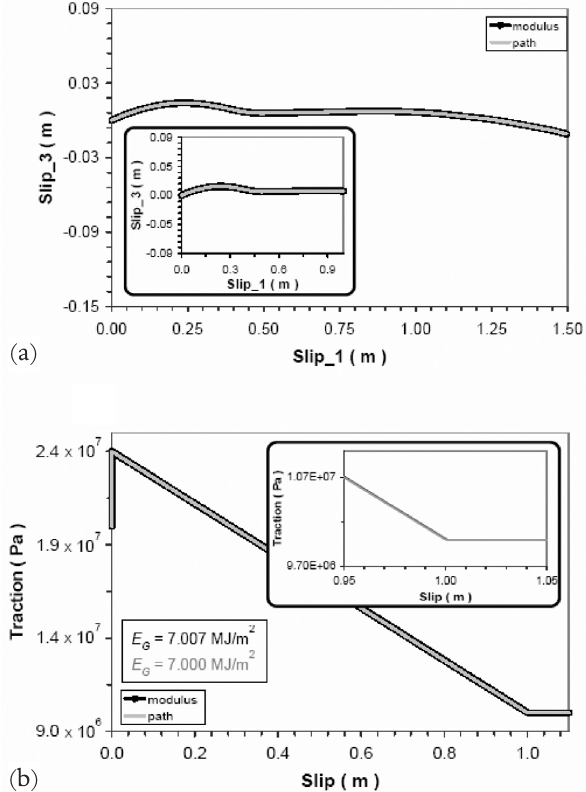
Figure 7. The same as in Figure 3, but now for the heterogeneous models of Figure